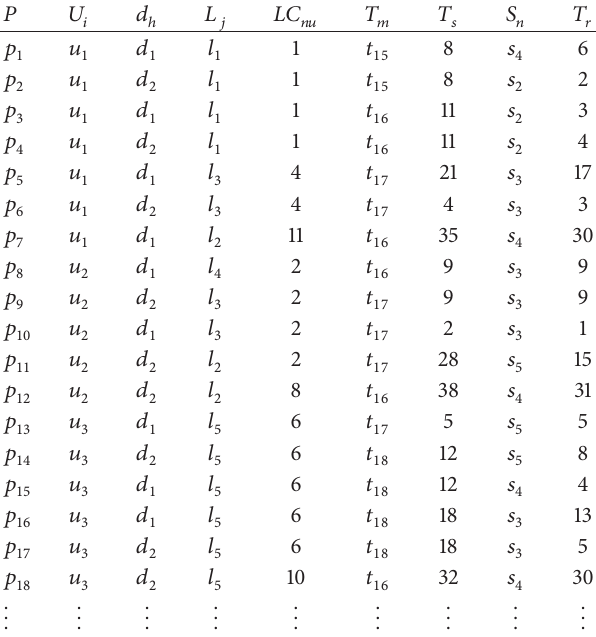
Table 4: Tourist behavior information